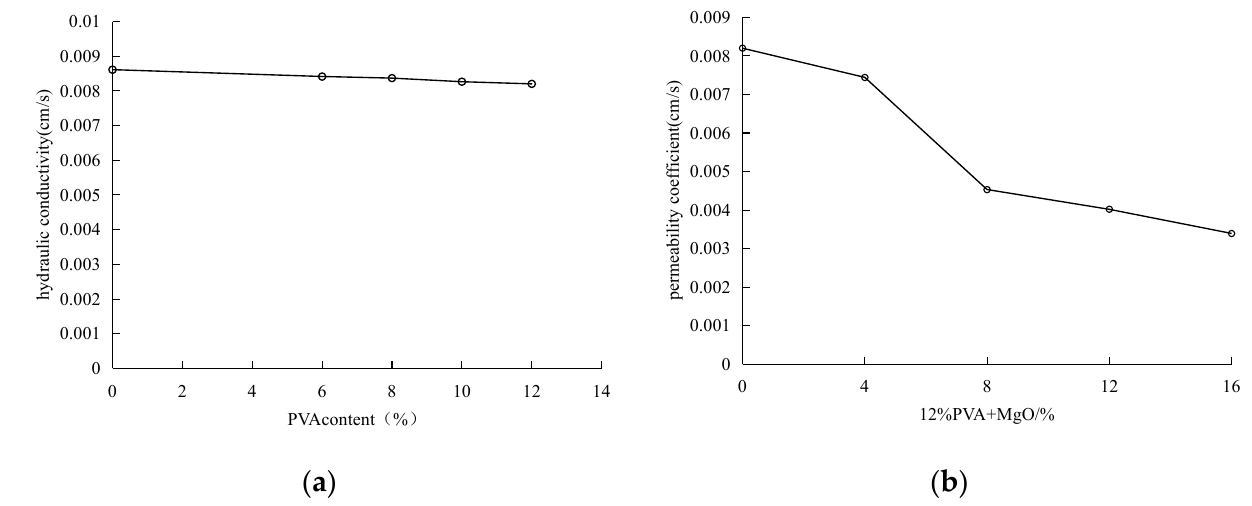
Figure 7. ( a ) Permeability coefficient curve of different PVA content; ( b ) Permeability coefficient curve of different MgO content; Variation curve of permeability coefficient.